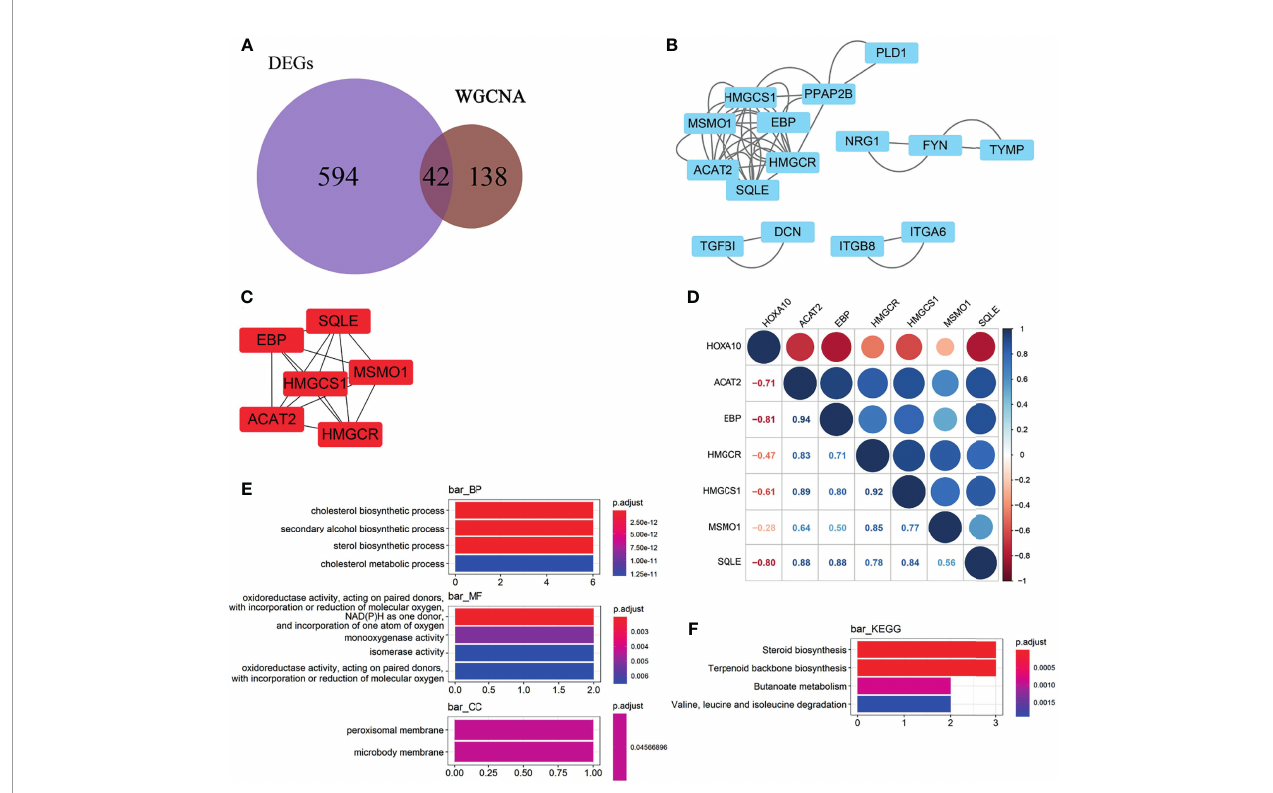
FIGURE 4 | Selection and enrichment analysis of the key genes. (A) Venn diagrams showing the candidate genes between the 636 DEGs and 180 HOXA10- associated genes. (B) PPI network of the candidate genes. (C) Key genes selected by MCODE APP. (D) Correlation between the HOXA10 and the six selected key genes. (E) GO enrichment analysis of the key genes. (F) KEGG enrichment analysis of the key genes (BP, biological process; CC, cellular component; MF, molecular